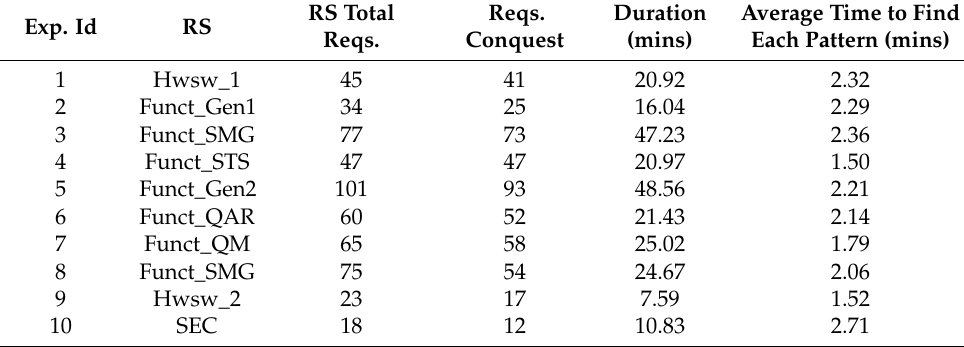
Table 9. Running time of the experiments.